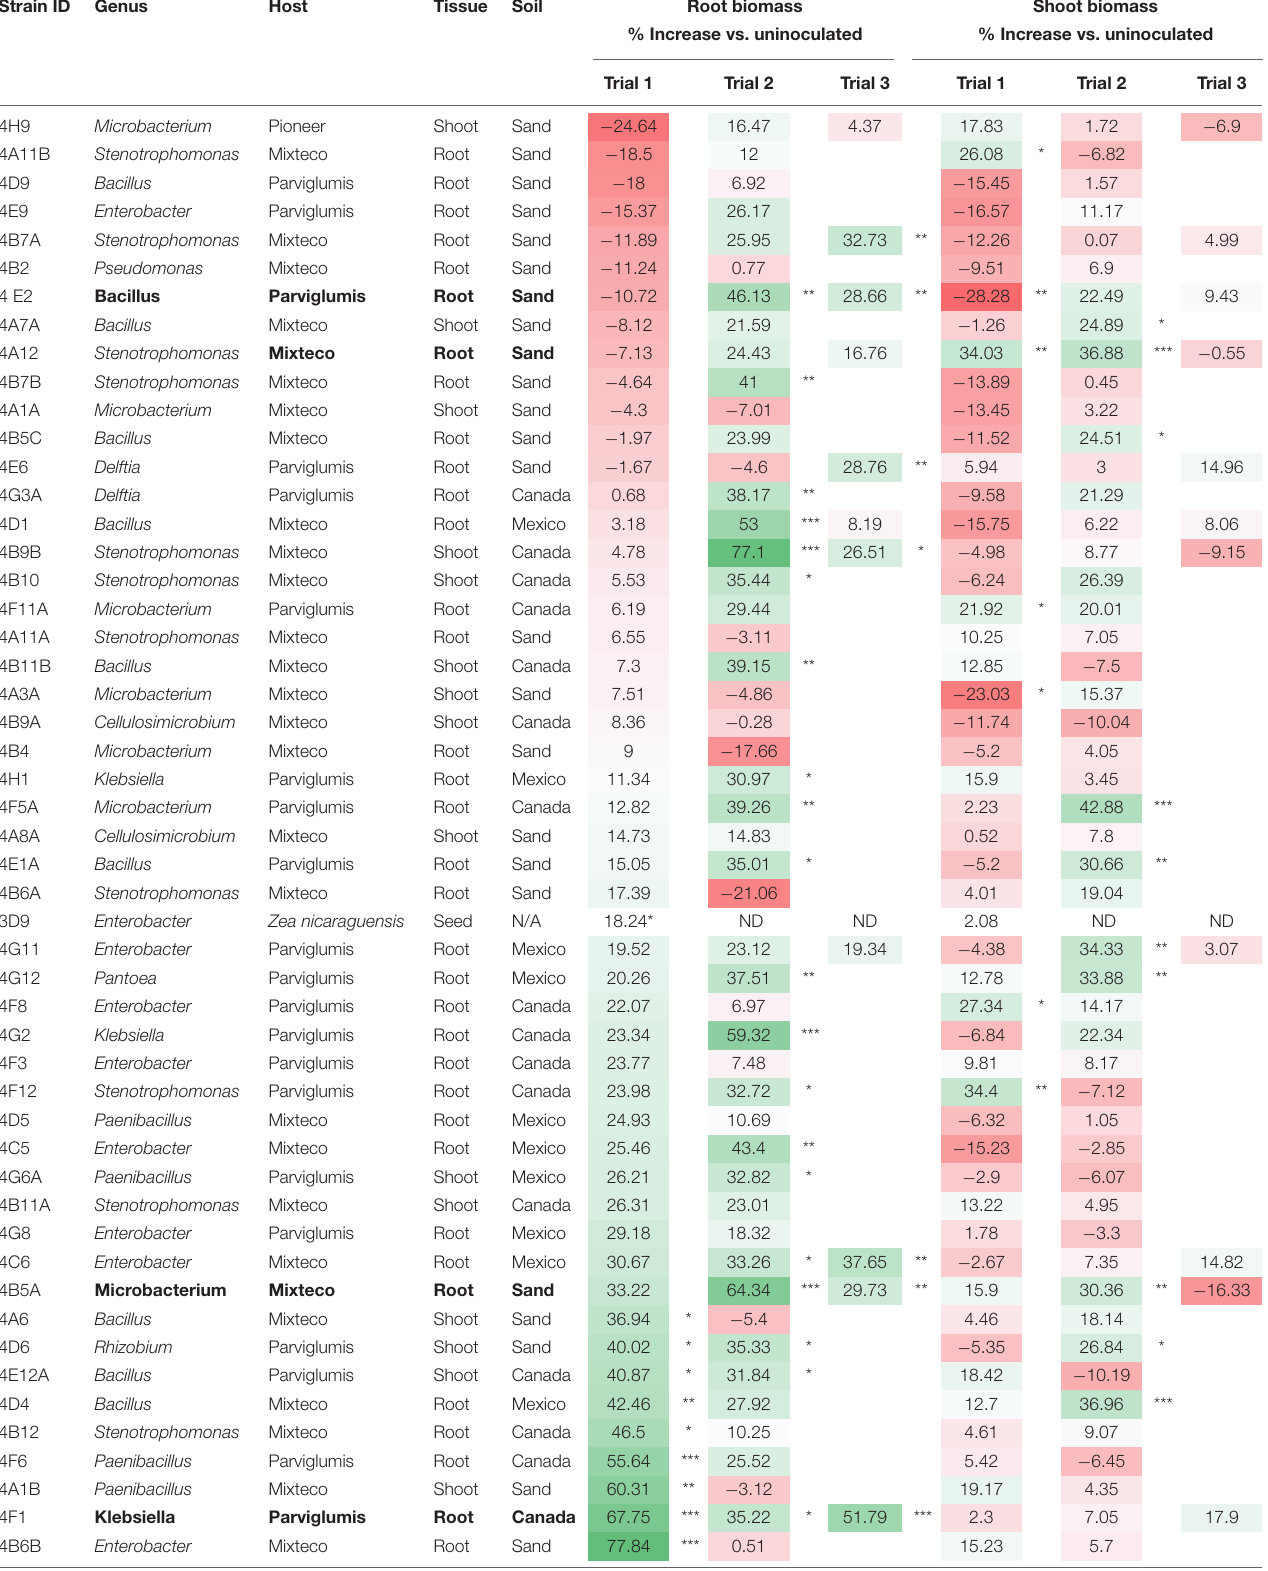
TABLE 3 | Summary of percent increases in annual ryegrass biomass following endophyte seed treatment compared to the respective uninoculated buffer control. Strain ID